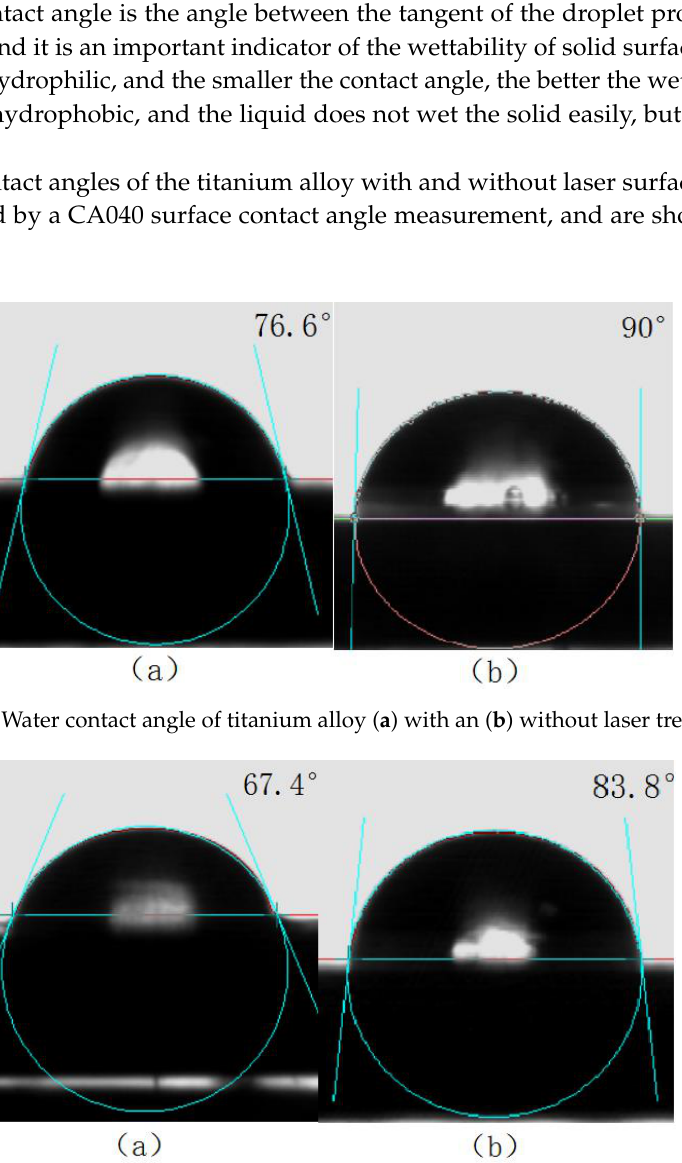
Figure 13. Ethylene glycol contact angle of titanium alloy ( a ) with and ( b ) without laser treatment.